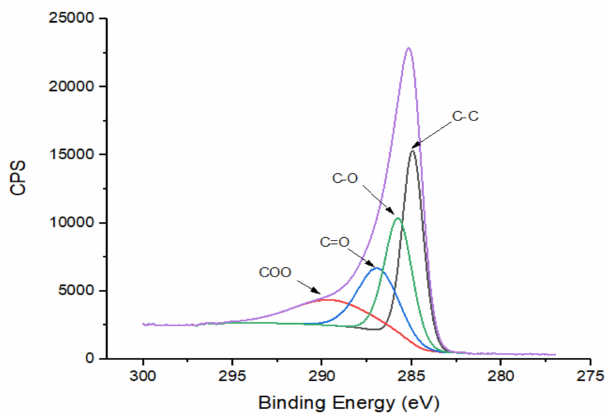
Figure 6. High-energy resolution XPS C 1s spectrum.